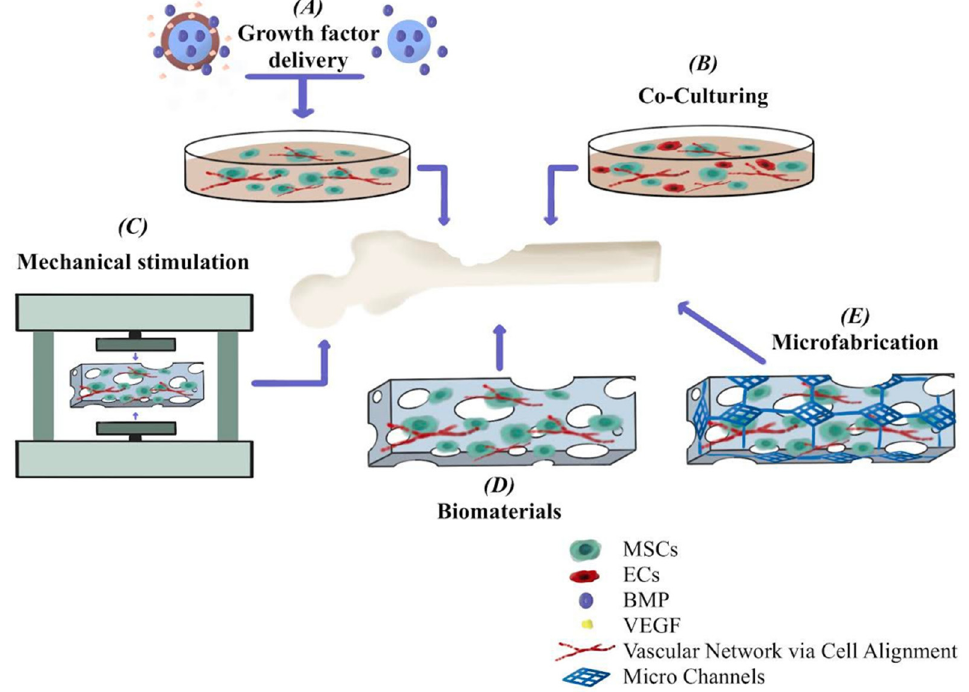
Figure 5. Bone regeneration process with the contribution of biomaterials.